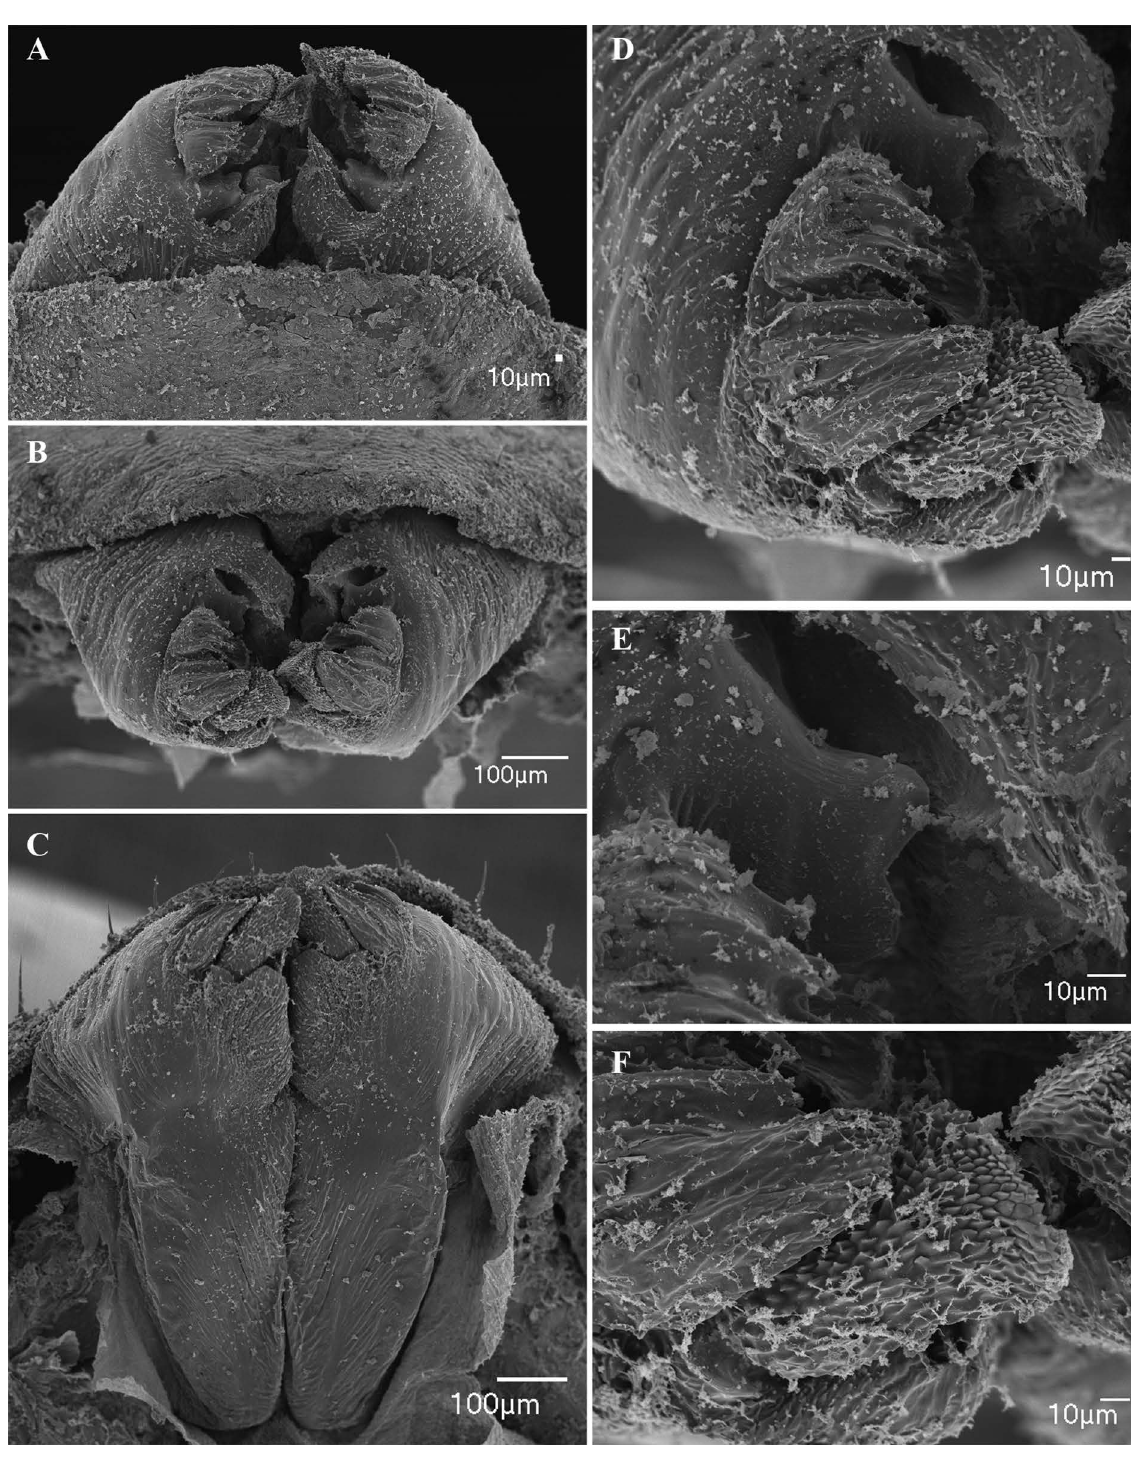
Fig. 25. Charinus miskito sp. nov. (SMNS), male gonopod. A . Ventral view. B . Posterior view. C . Dorsal view. D . Detail of the lateral lobe 2. E . Detail of processus internus. F . Detail of lateral lobe 1 and dorsal